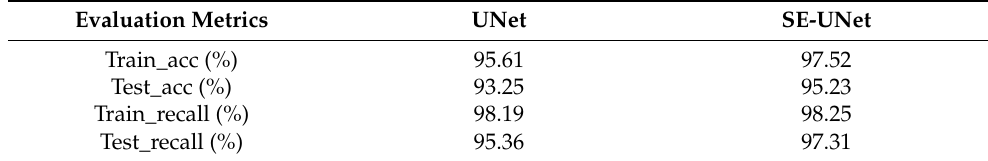
Table 2. Table of quantitative analysis of the UNet and SE-UNet